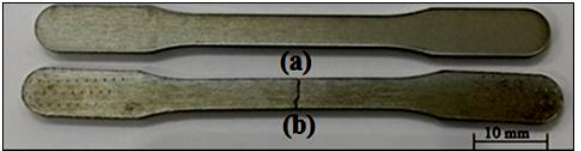
Figure 2. General view of Alloy 2 test specimen sintered at 1350 °C for 1 h. ( a ) before tensile test and ( b ) after tensile test.